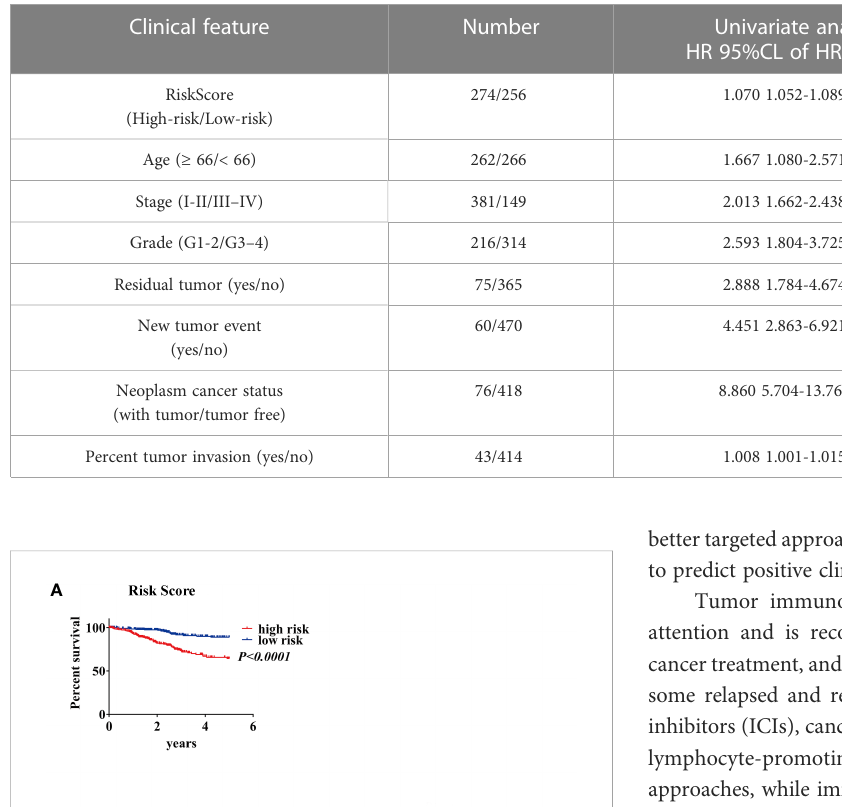
TABLE 3 Univariable and multivariable analyses for each clinical